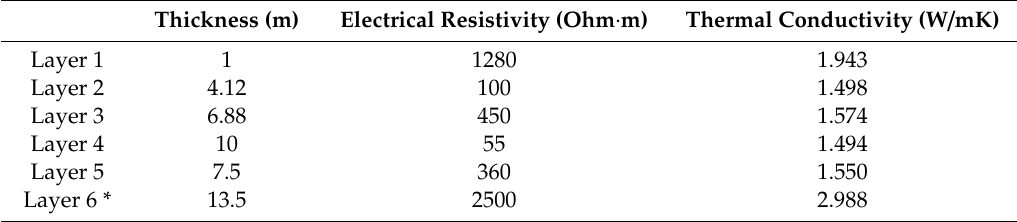
Table 5. Layers detected in the borehole under study, according to the interpretation of ERT results.